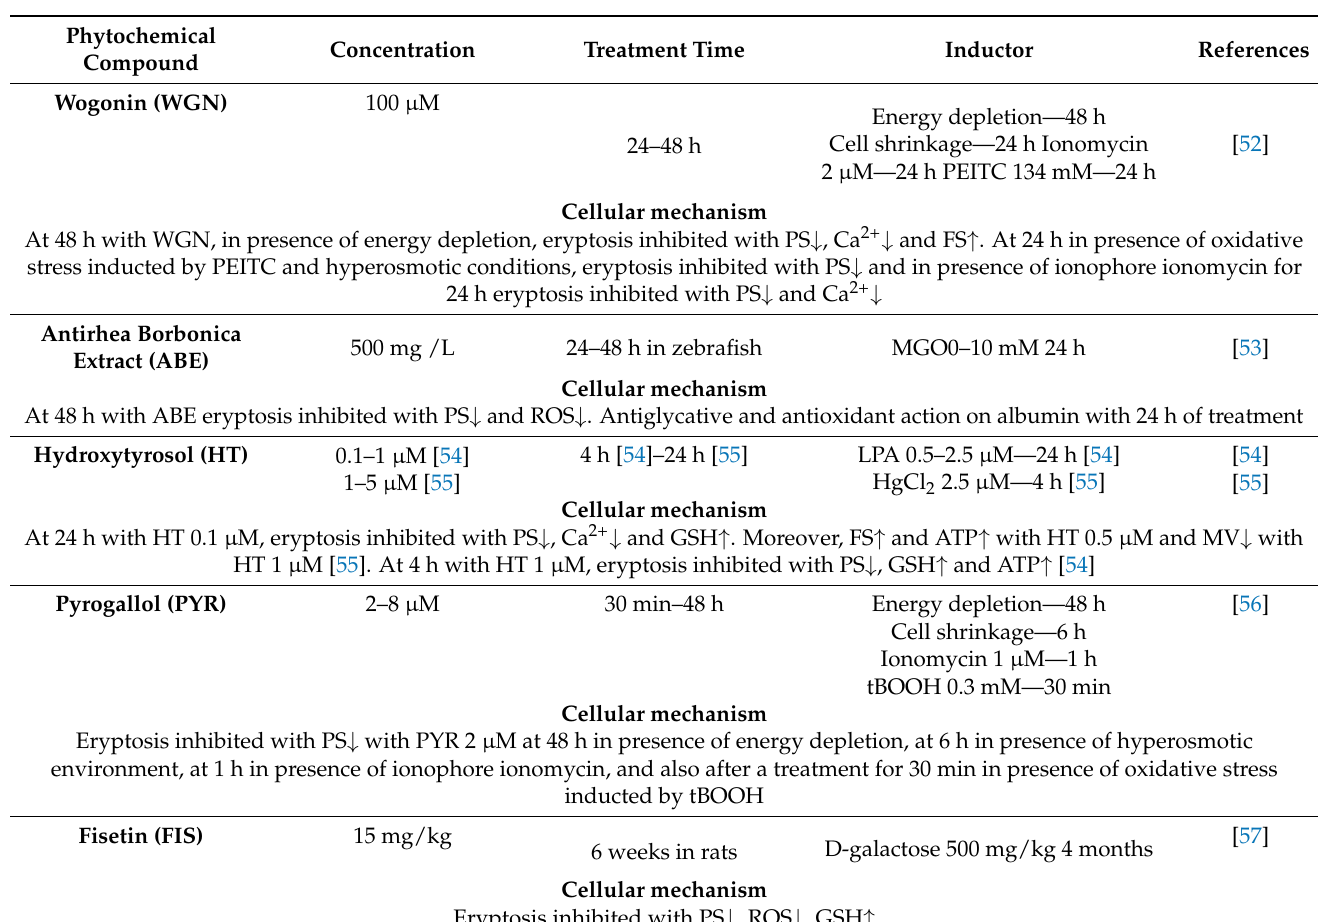
Table 1. Mechanisms involved in the anti-eryptotic effect of polyphenolic compounds against different stimuli in different type of